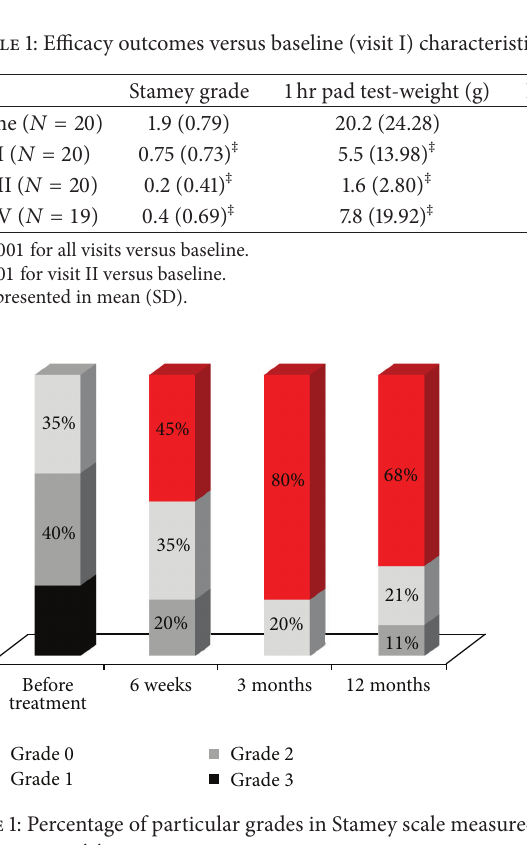
Figure 1: Percentage of particular grades in Stamey scale measured on subsequent